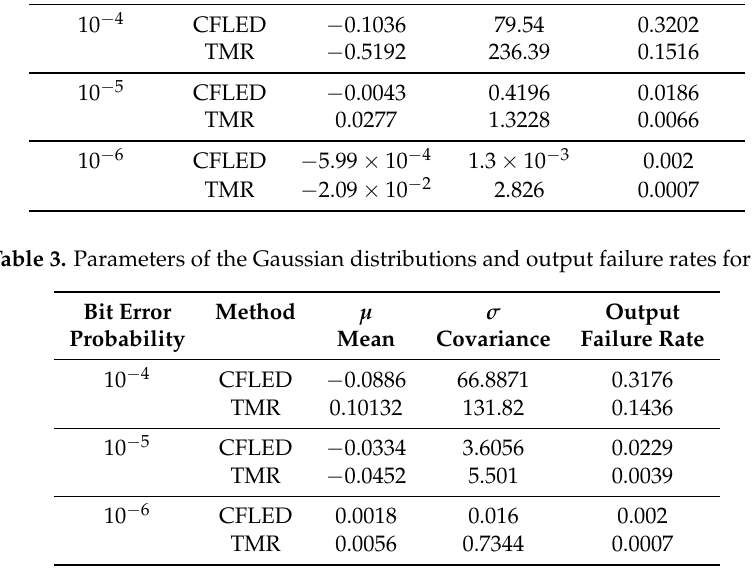
Table 2. Parameters of the Gaussian distributions and output failure rates for u r